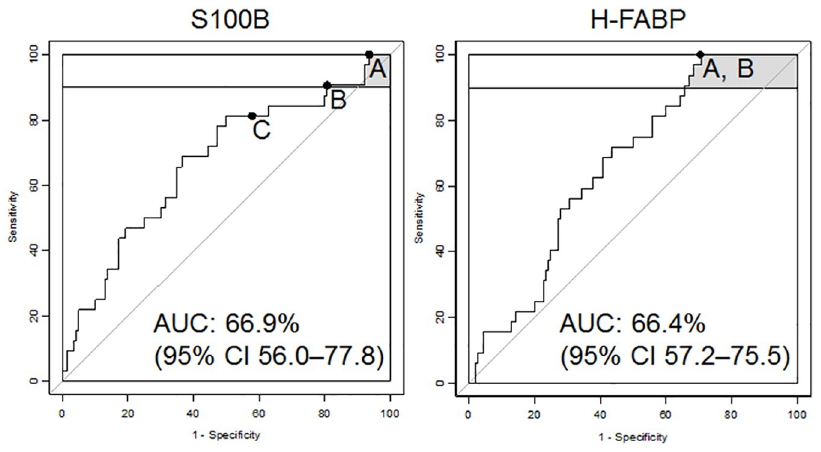
Fig 1. ROC curves, (cid:20) 6 h post-trauma, for S100Band H-FABP, representing best performance when set to: a) 100% sensitivity; b) 90%–100% sensitivity; and c) the S100B cut-off 0.1 μ g/L.